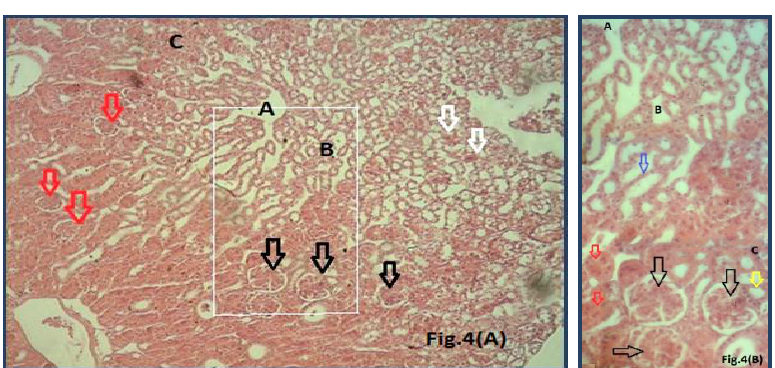
Figure, 6: Histological section of Harrier kidneys: (A) show: (A) Central vein. (B) Medulla. (C) Cortex. (Black arrows show mammalian Glomerulus-Red arrows show intermediate Glomerulus -White arrows show reptilian Glomerulus) H&E stain 100x. (B) is magnifying of white box in left figure shows ;( Red arrows show proximal convoluted tubules- yellow arrow shows distal convoluted tubule- blue arrow shows collecting tubule H&E